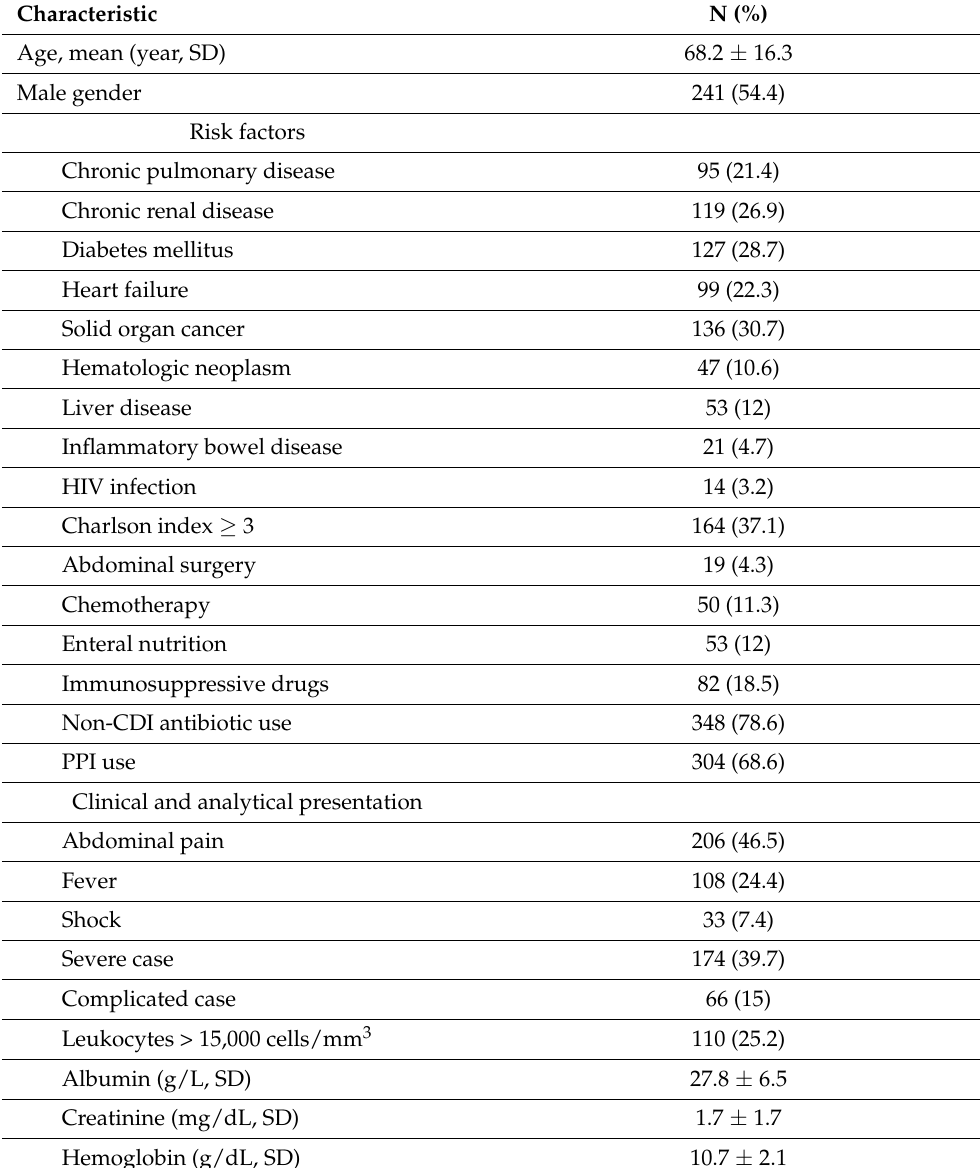
Table 1. Demographics, risk factors and clinical characteristics of patients included in the study (N = 443